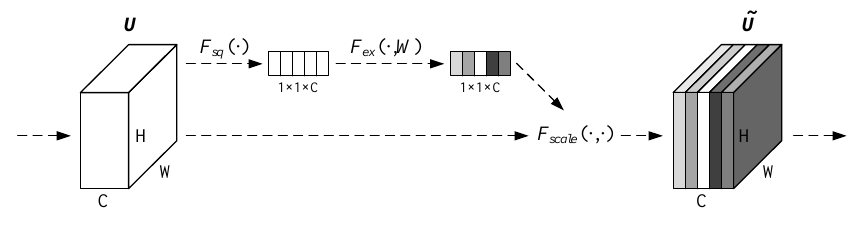
Figure 5. The architecture of the SE attention module.